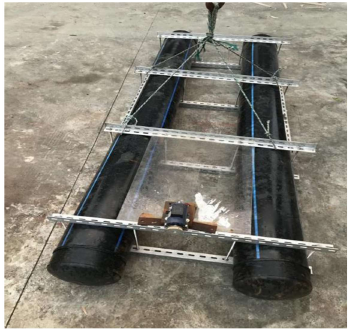
Figure 11. Traditional double-buoy breakwater.